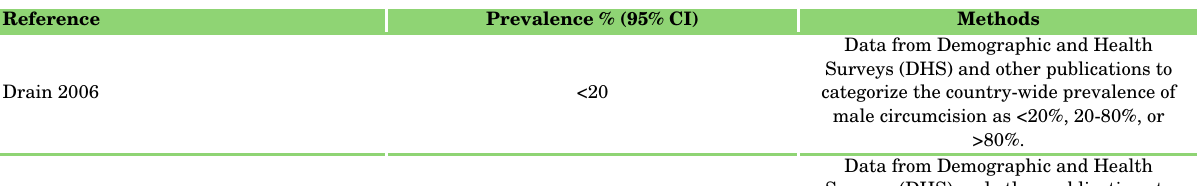
Table 47: Prevalence of male circumcision in Peru